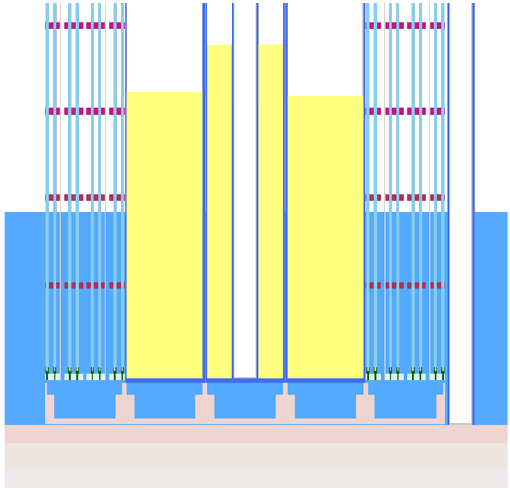
Figure 2. Illustration of central tube for neutron